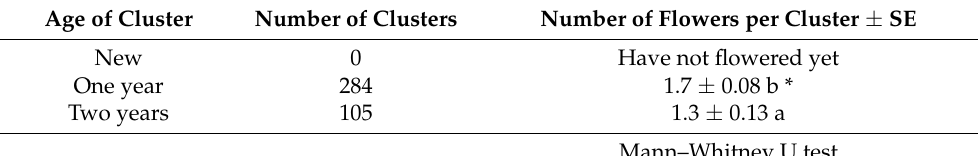
Figure 4. Vegetative development of one Ranunculus illyricus clone during a three-year period. Example: 11–mother cluster planted in 2016 produced two progeny clusters in 2017 (11.1 and 11.2) and three in 2018 (11.0.1, 11.0.2 and 11.0.3). In 2018, individual 11.1 produced four progeny clusters of tubers (11.1.1–11.1.4). Table 2. Effect of tuber cluster age on the number of flowers